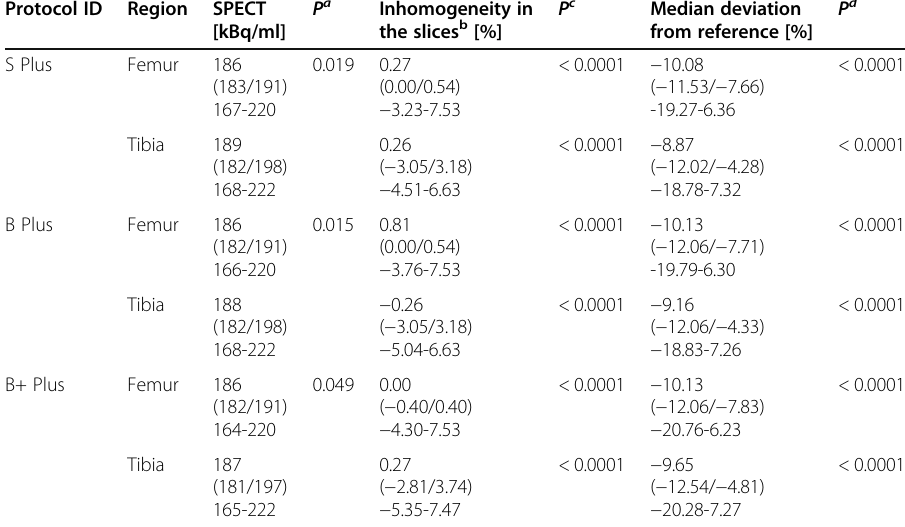
Table 2 Reconstructed activity concentration, inhomogeneity of reconstructed activity concentration in the anatomically oriented ROIs, and median deviation from the reference region for the optimized scan protocol (40 mA, pitch = 1.375, slicing = 3.75